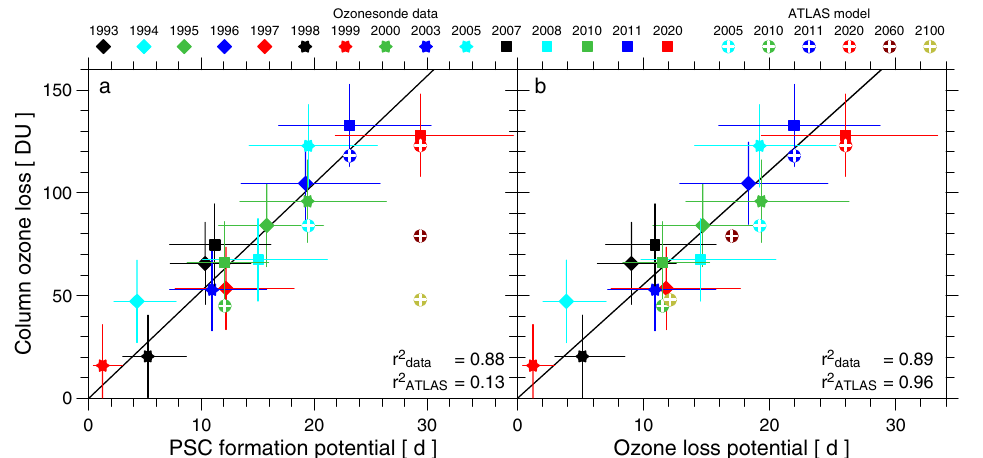
Fig. 1 Chemical loss of Arctic Ozone. a Chemical loss of column ozone ( Δ O 3 ) in Dobson Units (DU; 1 DU = 2.687 × 10 16 molecules cm − 2 ) inside the Arctic polar vortex determined by ozonesonde campaigns for various winters since 1993 versus PSC formation potential (PFP) computed from ERA5/ERA5.1 (closed symbols), calculated as the vertical integral of loss pro fi les between 380 and 550 K potential temperature, which is ~14 and ~24 km altitude. The error bars representing 1 σ uncertainty for ozone loss are based upon considerations such as uncertainties in the calculated cooling rates and the potential impact of mixing across the edge of the vortex edge as described in Harris et al. 17 ; the 1 σ uncertainty for PFP is derived by assuming an error of ±1 K in the ERA5/ERA5.1 temperature fi eld (see “ Methods ” ). Computations of Δ O 3 are found using the global ATLAS Chemistry and Transport Model that includes a comprehensive treatment of stratospheric chemistry, for the halogen loading and meteorological conditions of winter 2005, 2010, 2011, and 2020 as well as halogen loading for 2060 and 2100 with meteorological conditions for 2020 (symbols with crosses). The ATLAS values of Δ O 3 are also based on integrals between the 380 and 550 K potential temperature 20 . b Same as panel a except ozone loss potential (OLP) is used for the abscissa. The variance in observed (data) and modelled (ATLAS) Δ O 3 explained by PFP and by OLP is reported as the square of the correlation coef fi cient in both panels. The solid line on both panels shows a linear, least-squares fi t to the 15 ozonesonde data points, forced through the